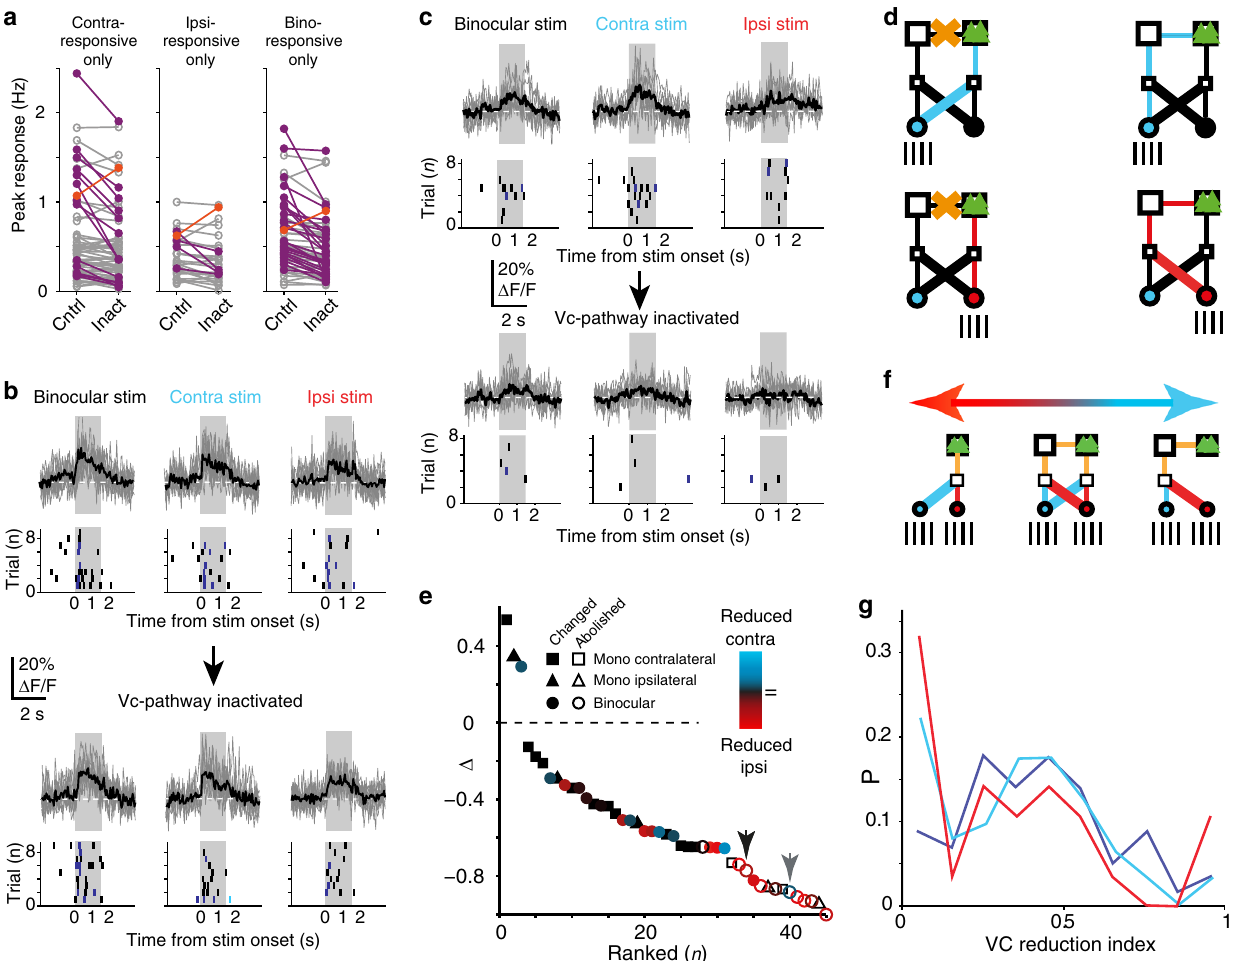
Fig. 4 Callosal pathway modulates spiking responses in binocular and monocular neurons. a Firing rate changes for maximum response angle from visually responsive neurons without (control, Cntrl) and with (Inact.) callosal pathway inactivation for contralaterally only (left), ipsilaterally only (middle) and binocularly (right) responsive neurons. Signi fi cant (purple, orange) and non-signi fi cant (gray) changes depicted. b Example responses from a neuron not in fl uenced by vc pathway inactivation. Upper panel, example of Ca 2 + -transients from each stimulus trial (gray) and resulting average (black) during binocular (left), contralateral (middle), and ipsilateral eye stimulation (right) for maximum response angle (see “ Methods ” section), inferred spikes (singles black, doubles dark blue, triples light blue) from transients for each trial (8 trials). Lower panel, same as in upper panel, but with vc pathway inactivation. c Example responses from a neuron showing a strong vc pathway inactivation effect. Convention same as in b . d Visual pathways activated during control and vc inactivation conditions, conventions as in Fig. 3h. e Graph depicting amount of signi fi cant fi ring rate change in binocularly (circles), ipsilaterally (triangles), and contralaterally (squares) responsive neurons during silencing of the callosal pathway (same as purple and orange in a ). Neurons ranked from those that increased fi ring rates to those that decreased fi ring to not signi fi cantly different from spontaneous activity (open symbols). Symbol color denotes whether ipsilateral (red) or contralateral (turquoise) response decreased most or both decreased equally (black). Black arrow depicts example neuron shown in c , gray arrow depicts example neuron shown in Supplementary Fig. 10. f Visual pathways activated during binocular stimulation, showing different amounts of contribution of the vc pathway, ranging from responses being completely reliant on (right) to being independent of (left) vc pathway activation. g Probability distribution of the amount of in fl uence of the vc pathway on responses, quanti fi ed as the vc reduction index for binocularly (blue), ipsilaterally (red), and contralaterally (turquoise) responsive ipsilaterally responsive neurons, responses to visual stimuli at the preferred orientation were reduced to spontaneous rates for a small number of neurons ( N = 2 contralaterally responsive neu- rons, N = 2 ipsilaterally responsive neurons). To more directly compare the contribution from the vc pathway for monocular and binocular neurons, we calculated the vc reduction index. This index was bounded between 0 and 1, with 0 denoting no con- tribution from the vc pathway and 1 denoting complete reliance on the vc pathway (see “ Methods ” section for details). As for the binocular neurons, the majority of neurons ’ monocularly driven